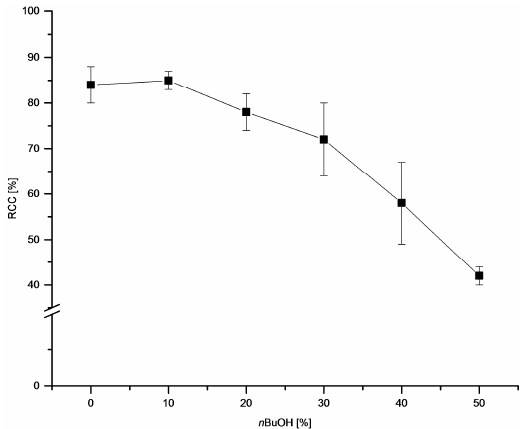
Figure 4. Dependency of RCC on n BuOH content. Conditions: [ 18 F]Fluoride (~50 MBq) was eluted from a QMA-CO 3 cartridge with a solution of Et 4 NOTf (3.1 mg, 11 µmol) in MeOH (500 µL) (see